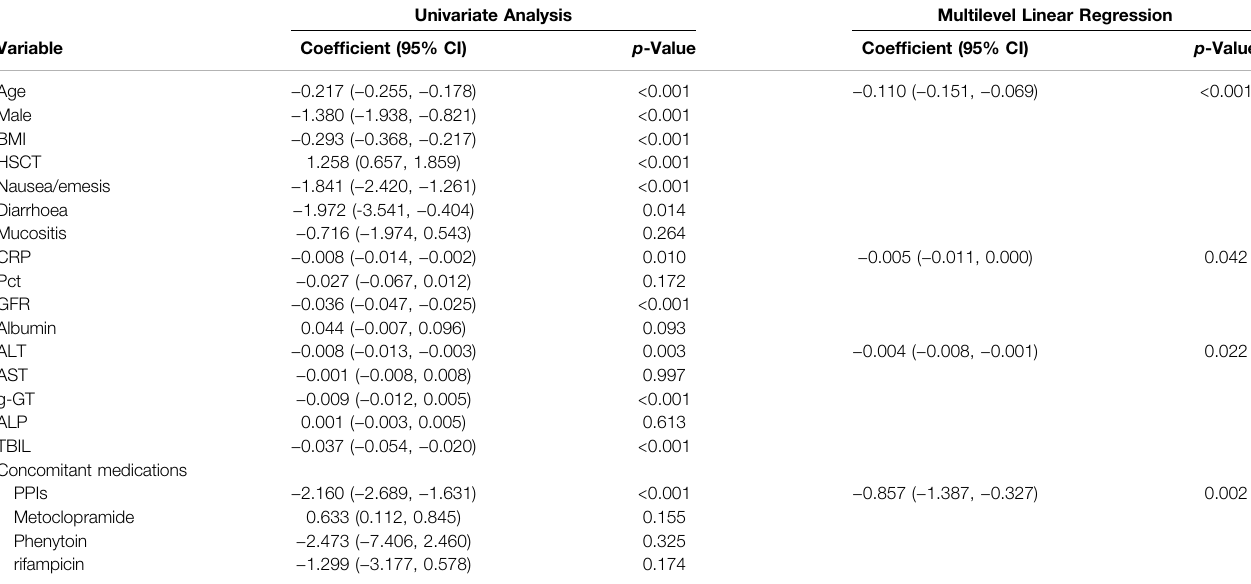
HSCT,Allogeneichematopoieticstem celltransplantation; CRP,C-reactiveprotein; Pct, ProcalcitoninCreatinineclearance;GFR, Glomerular fi ltrationrate; PPIs, Protonpump inhibitors; ALT, Alanine transaminase; AST, Aspartate transaminase; g-GT, g-Glutamyltranspeptidase; ALP, Alkaline phosphatase; TBIL, Total bilirubin. Bold formatting signi fi es statistically signi fi cant covariates.